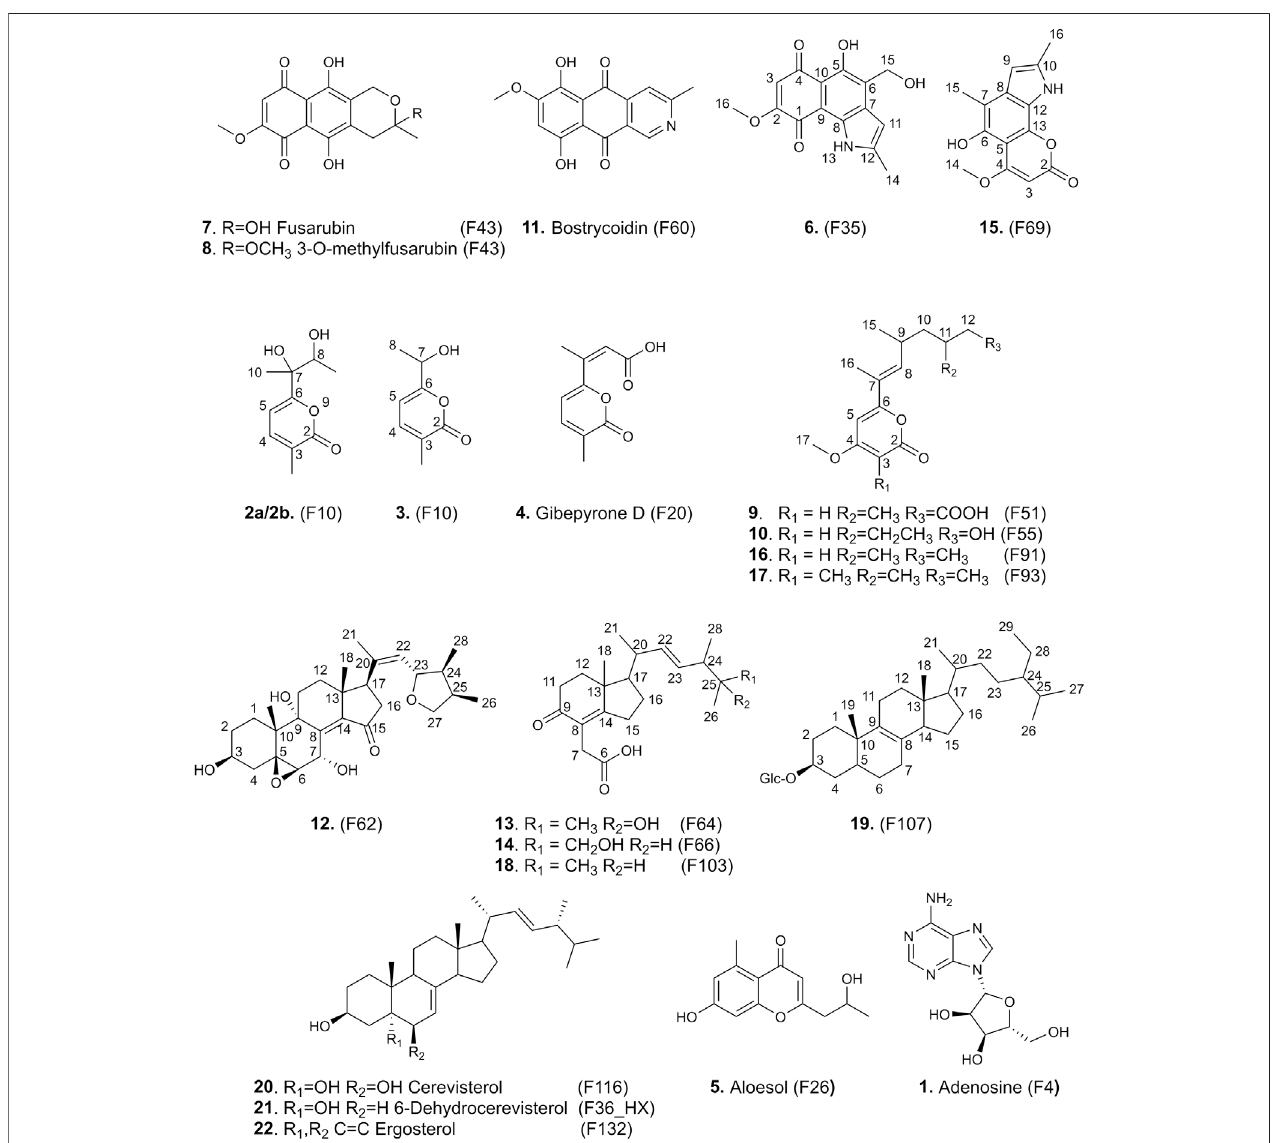
FIGURE 4 | Structures of the isolated compounds 1 – 22